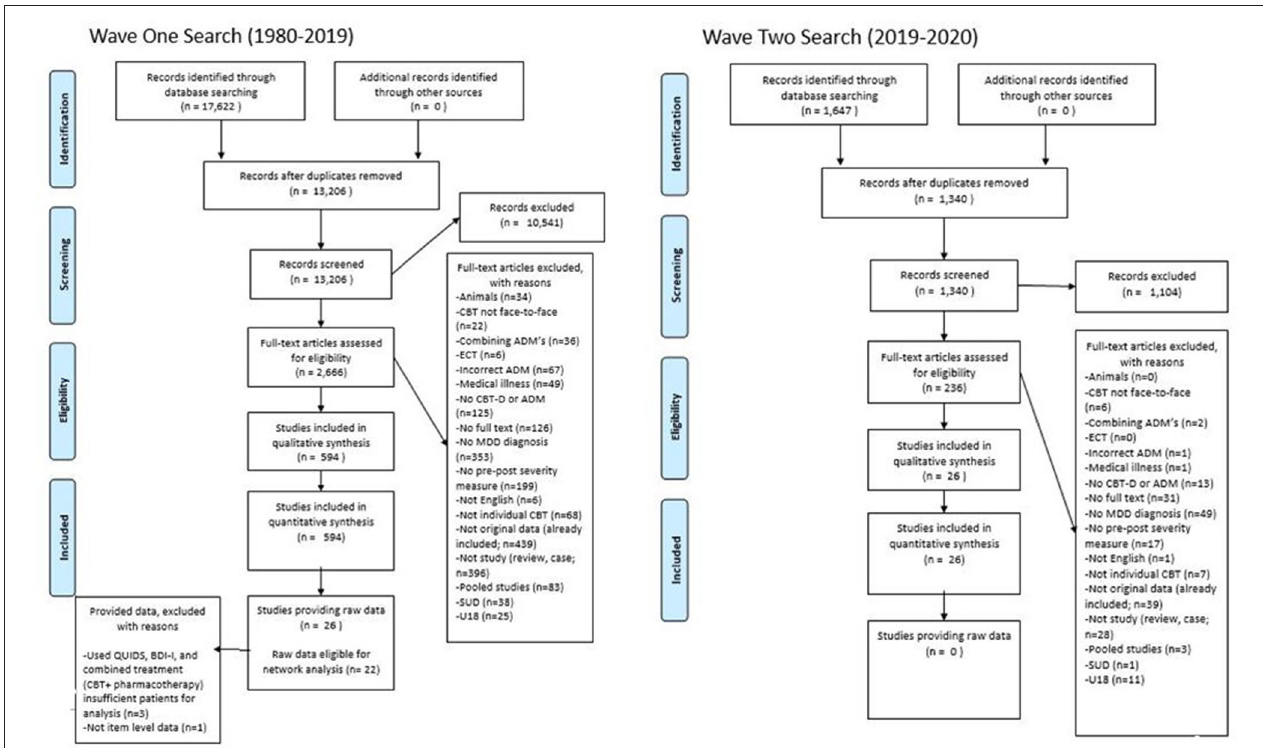
FIGURE 1 | PRISMA Flowchart of the review process and criteria for study selection.